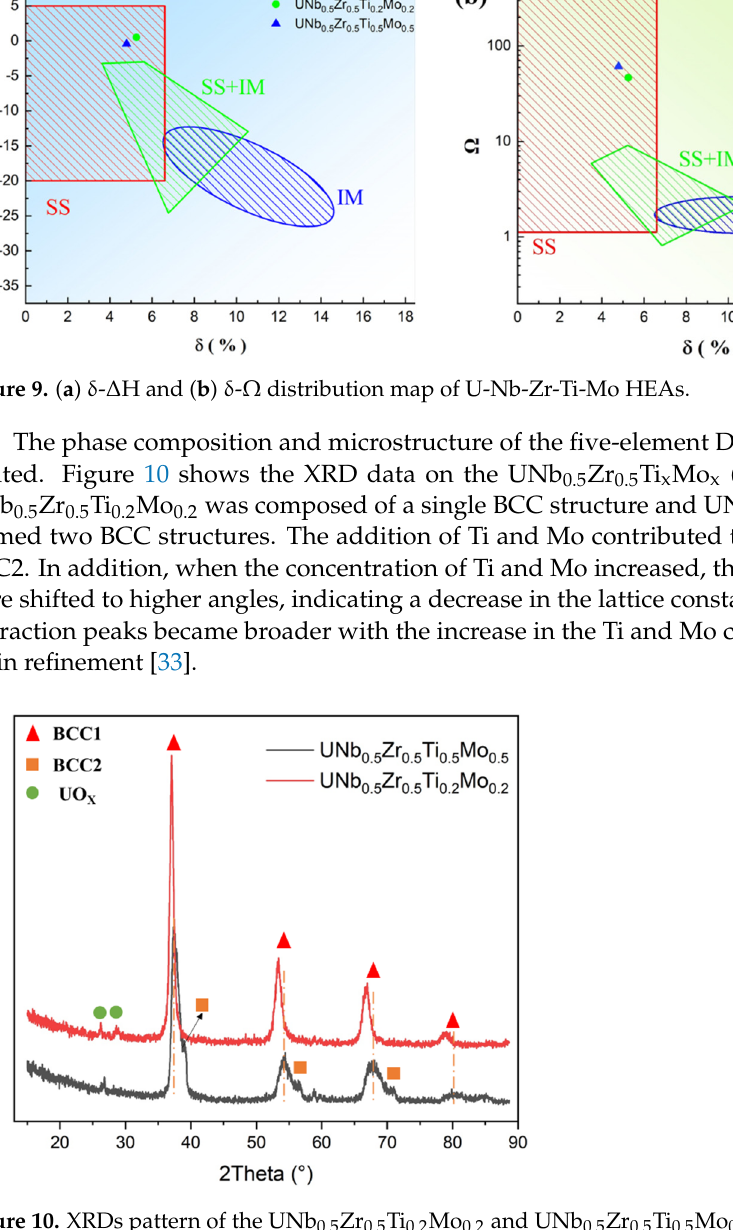
Figure 10. XRDs pattern of the UNb 0.5 Zr 0.5 Ti 0.2 Mo 0.2 and UNb 0.5 Zr 0.5 Ti 0.5 Mo 0.5 HEAs. The as-cast structures of the UNb 0.5 Zr 0.5 Ti 0.2 Mo 0.2 and UNb 0.5 Zr 0.5 Ti 0.5 Mo 0.5 alloys are shown in Figure 11. These alloys had a typical cast dendritic structure of a uniform composition region and U-enriched region between the dendritic structures. It can be observed that the structure segregation phenomenon of the alloys improved as Ti and Mo concentrations increased. This was due to the fact that Mo had a high melting point (higher than U’s melting point) and element redistribution during solidification. The alloy components are equally distributed without noticeable segregation, as seen in the surface scan findings of UNb 0.5 Zr 0.5 Ti 0.2 Mo 0.2 in Figure 12. The Brinell hardness and yield strength of the UNb 0.5 Zr 0.5 Ti x Mo x HEAs are listed in Table 9. The addition of Ti and Mo promoted the hardness and yield strength of the alloys, and plasticity reduced dramatically. The mixing enthalpy of Mo with Nb, Zr, and Ti was negative, and Mo had a higher melting point, resulting in component segregation. It can be demonstrated by examining UNb 0.5 Zr 0.5 Ti 0.5 Mo 0.5 , which has a higher hardness of 350 HB than that of UNb 0.5 Zr 0.5 Ti 0.2 Mo 0.2